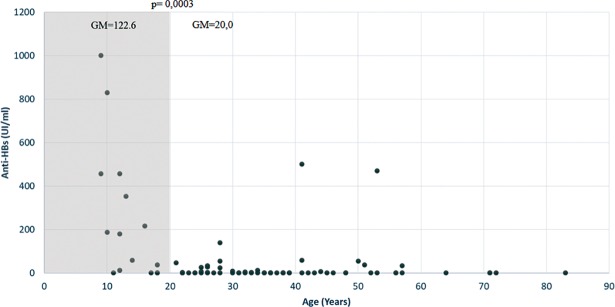
Distribution anti-HBs titres (IU/ml) by age in population Amerindian Warao.The gray shadow indicates the group under 20 years of age with anti-HBs titers significantly higher (p = 0.01) than those obtained in the population over 20 years of age. GM refers to the geometric mean of the anti-HBs titer.